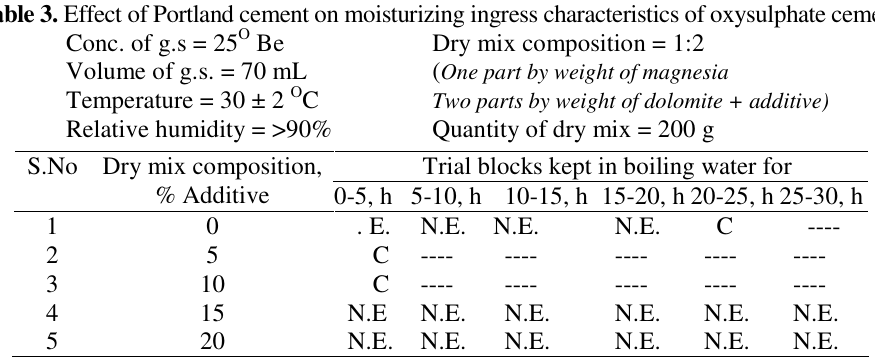
Table 3. Effect of Portland cement on moisturizing ingress characteristics of oxysulphate cement. Conc. of g.s = 25 O Be